Question: Write a descriptive caption for this figure.
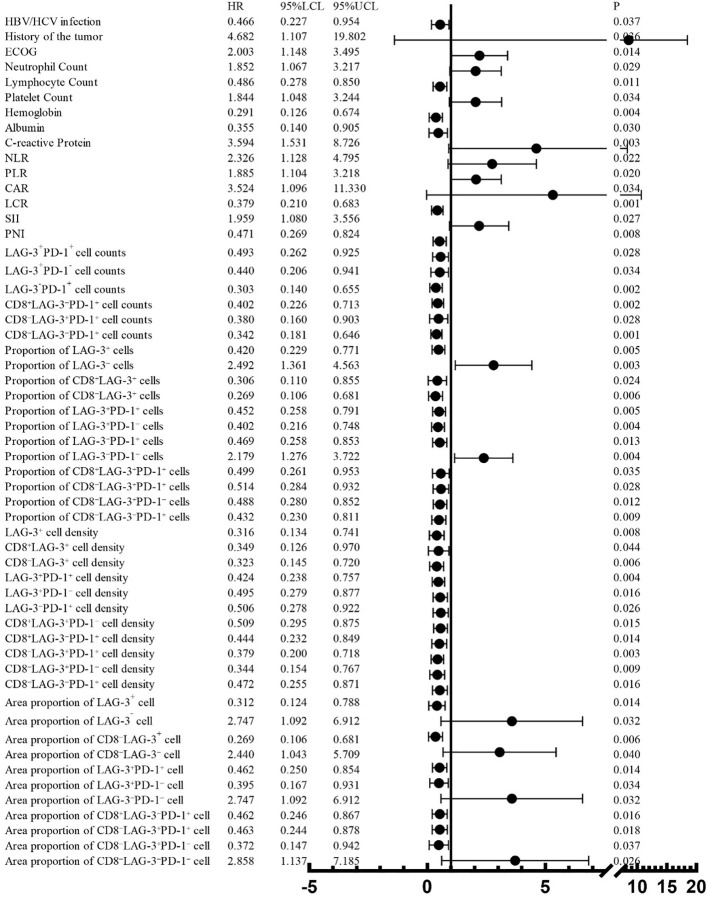
Answer: Forest plot of univariate Cox regression analysis for PFS in hepatocellular carcinoma patients receiving targeted plus immunotherapy.